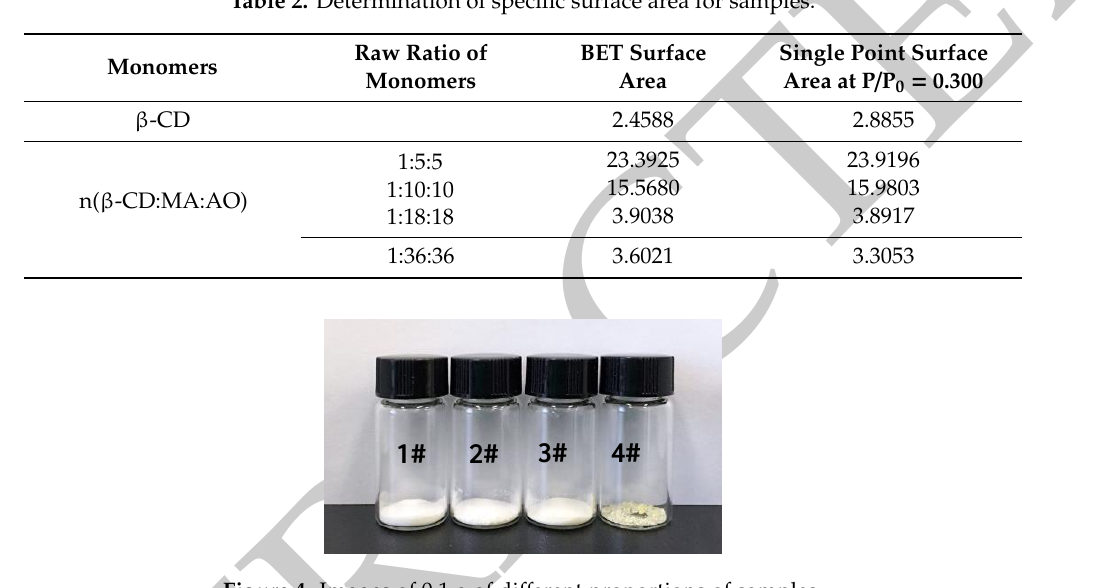
Table 2. Determination of specific surface area for samples.